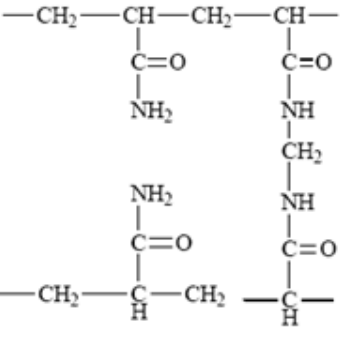
Figure 4. Representative segment of crosslinked